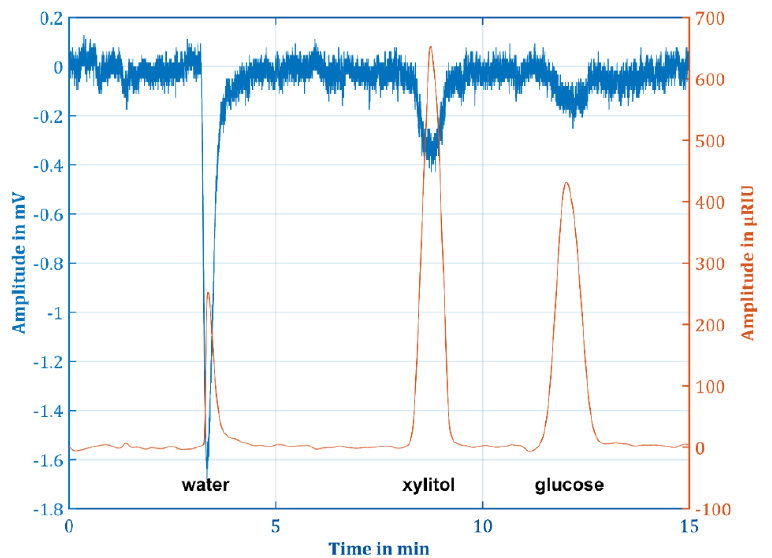
linear regression (parameters given in Equation (6)) with an R 2 of 99.42 %.